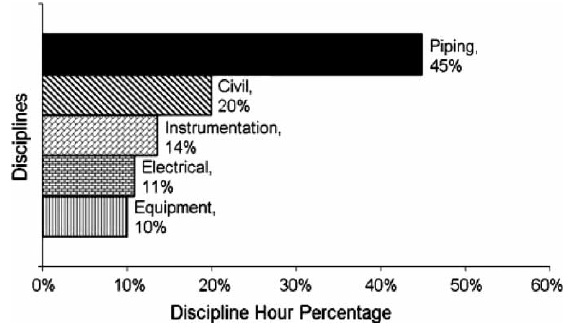
Fig. 1. Work-hour distributions in the EPMS